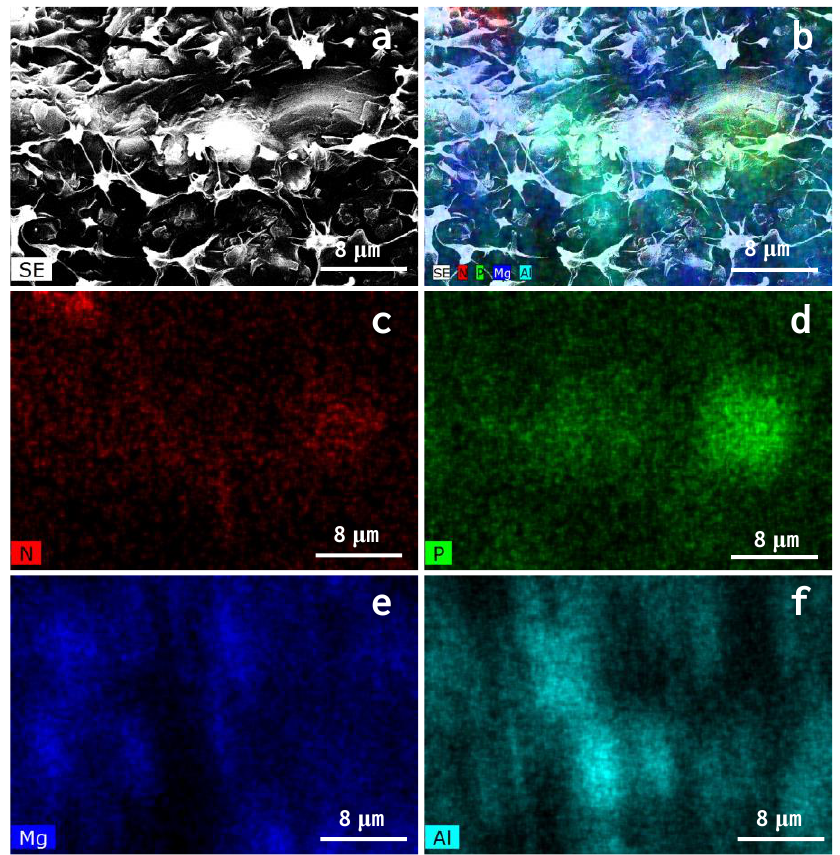
Figure 5. SEM ( a ) and EDS images ( b – f ) of PE‐CN‐5.